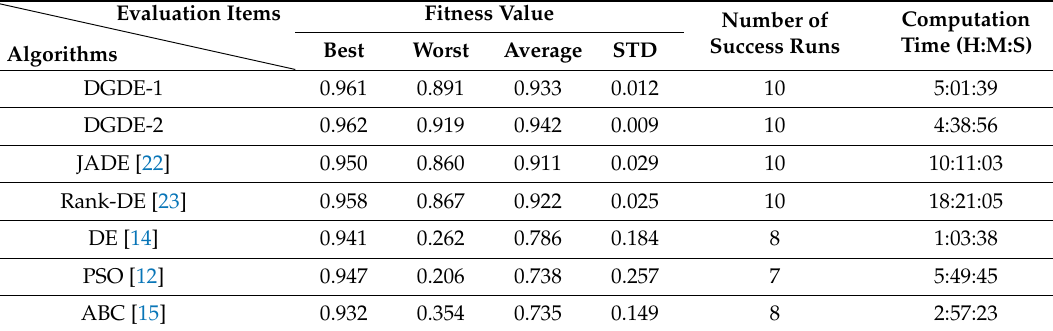
Table 3. Performance comparison of various algorithms in the wall-following control behavior.